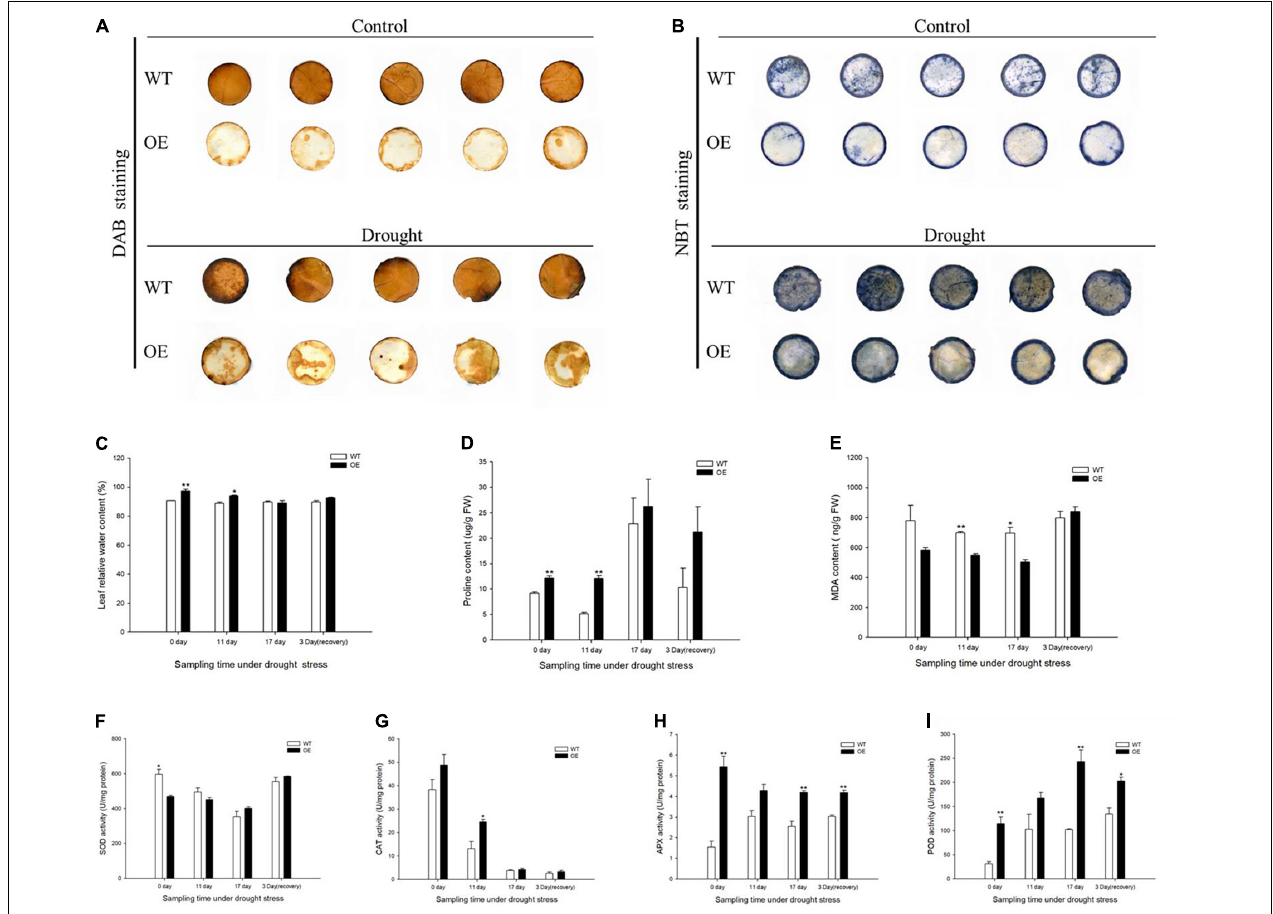
FIGURE 5 | Overexpression of PpCCoAOMT promotes tolerance to drought stress. (A) Diaminobenzidine (DAB) (displaying H 2 O 2 ) staining of leaves from WT and OE seedlings under normal and drought stress treatment. (B) Nitro blue tetrazolium (NBT) (displaying O 2 – ) staining of WT and OE leaves under normal and drought conditions. (C) Mean leaf relative water content (RWC), (D) proline content, (E) malondialdehyde (MDA) content, and (F) superoxide dismutase (SOD), (G) catalase (CAT), (H) ascorbate peroxidase (APX), and (I) peroxidase (POD) activities in WT and OE plants during drought stress and recovery periods. Data are means ( ± SDs) of triplicates. Significant differences between WT and OE lines were determined using independent samples t- tests. * P < 0.05, ** P < 0.01.